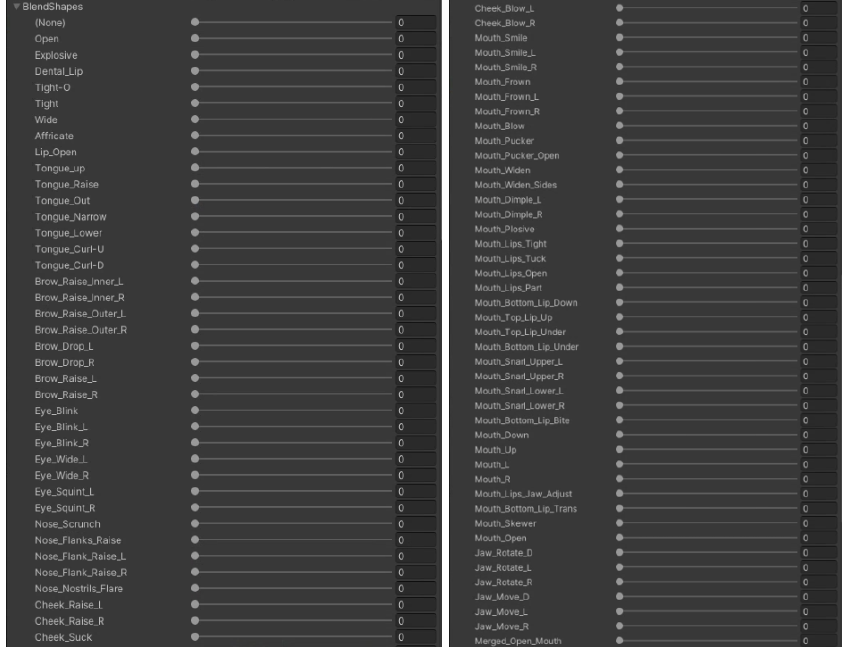
Figure 7. List of blendshapes for the avatar’s